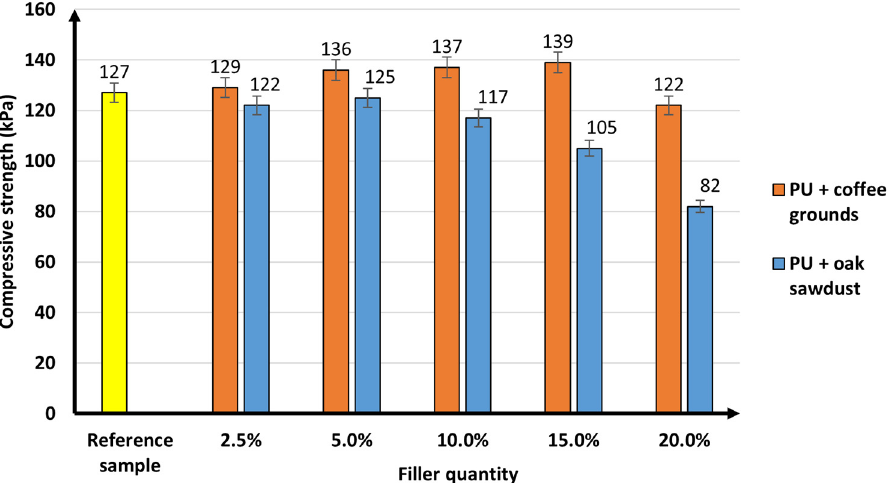
Figure 5. Compressive strength at 10% relative deformation of the reference sample and polyurethane composites.